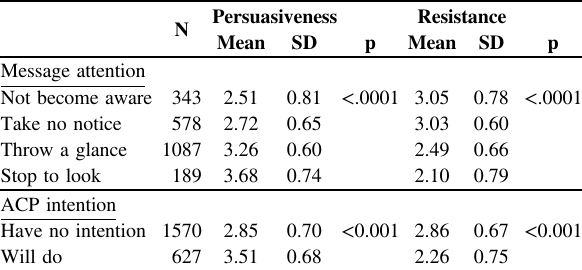
Table 5 Association with message attention and ACP intention Persuasiveness N